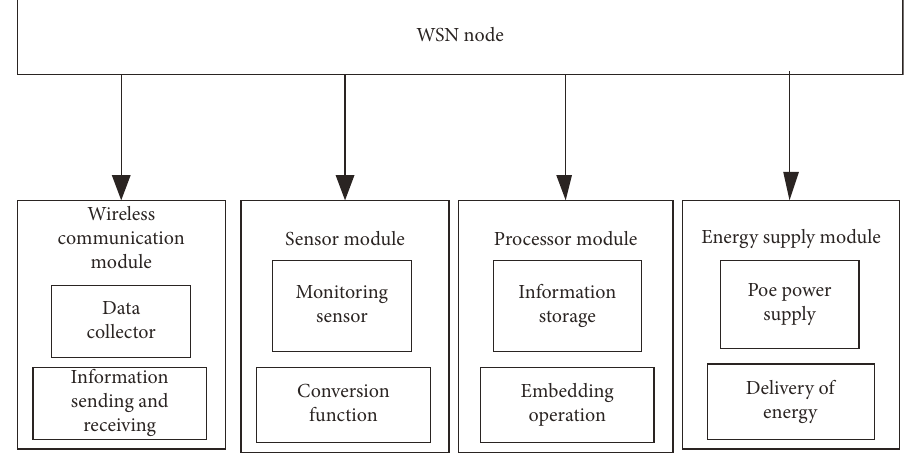
Figure 1: Composition of the sensor